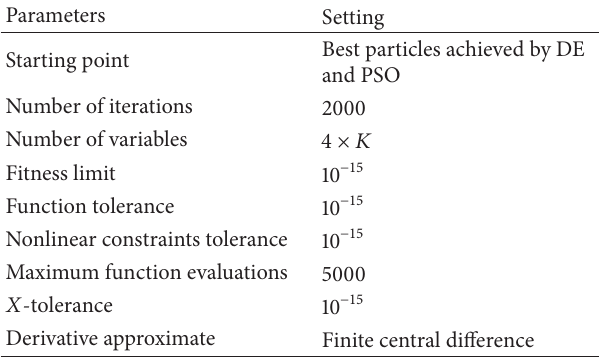
Table 1: Parameters setting for